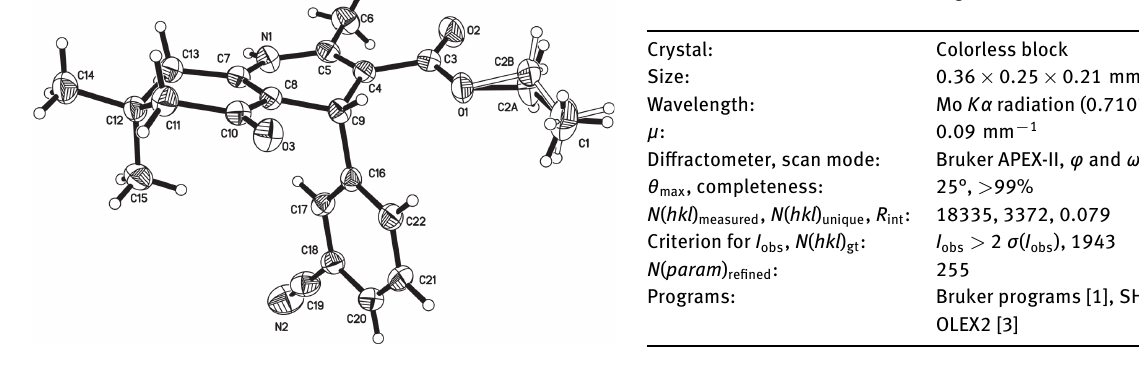
Table 1: Data collection and handling.